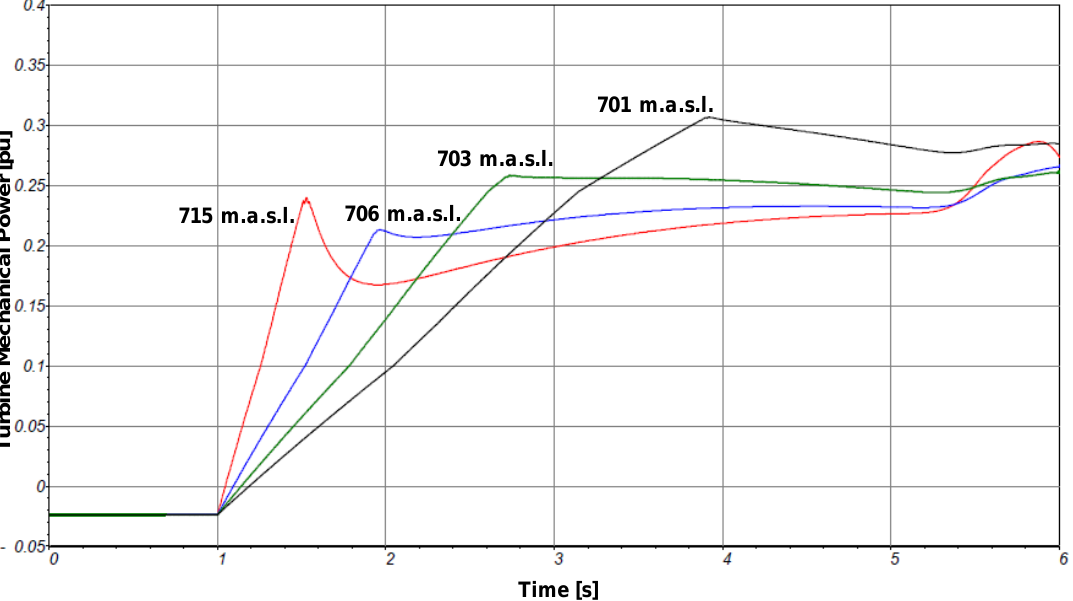
Figure 12. Frequency in the power system after a wind generator trip for different upper reservoir levels (20 s) after a 2.3 MW wind generator trip.